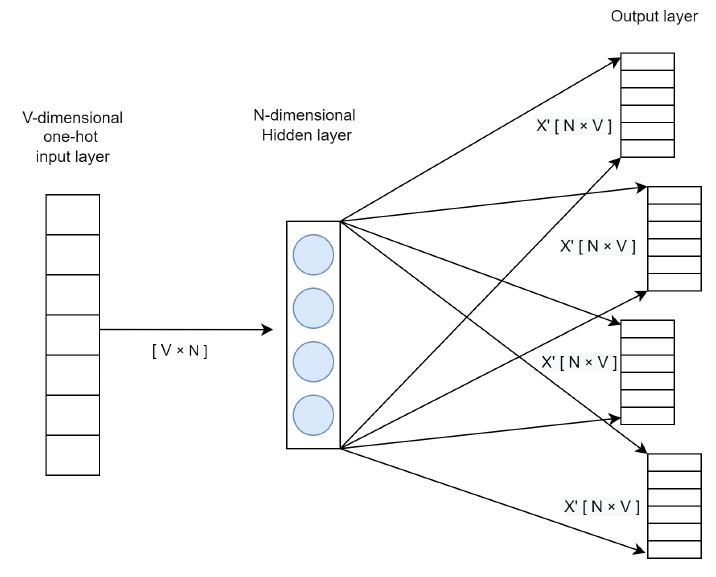
Figure 2. Skip-gram